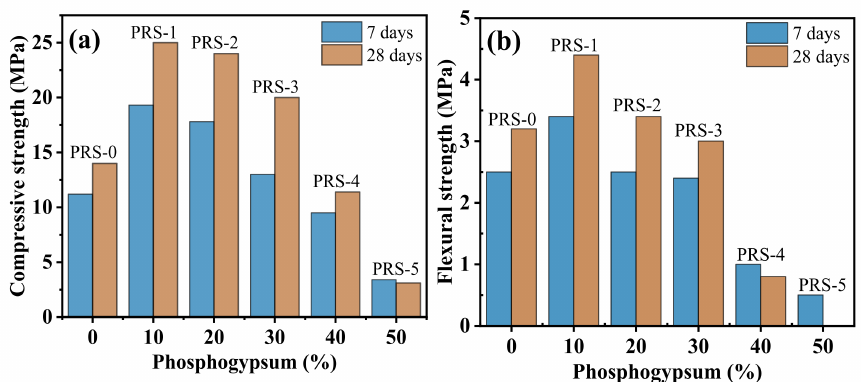
Figure 10. ( a ) Compressive strength and ( b ) flexural strength of composite cementitious material at 7 days and 28 days with different phosphogypsum